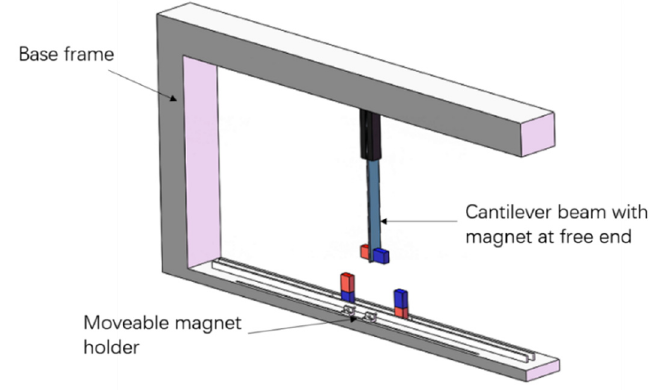
Figure 13. Possible experimental implementation.